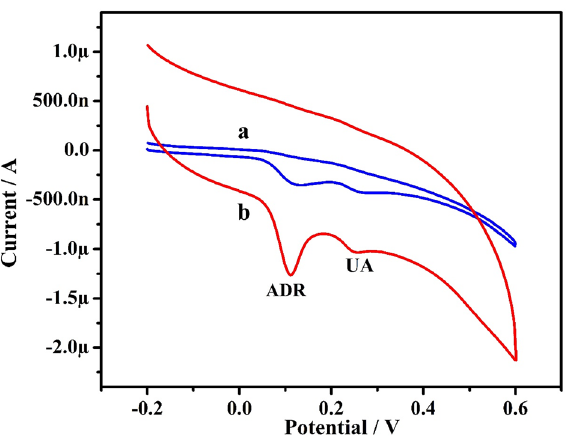
Figure 9. Resulted CVs for simultaneous studies of ADR (0.1 mM) and UA (0.1 mM) at bare GPE (curve ‘a’) and Po-ERY/MGPE (curve ‘b’).